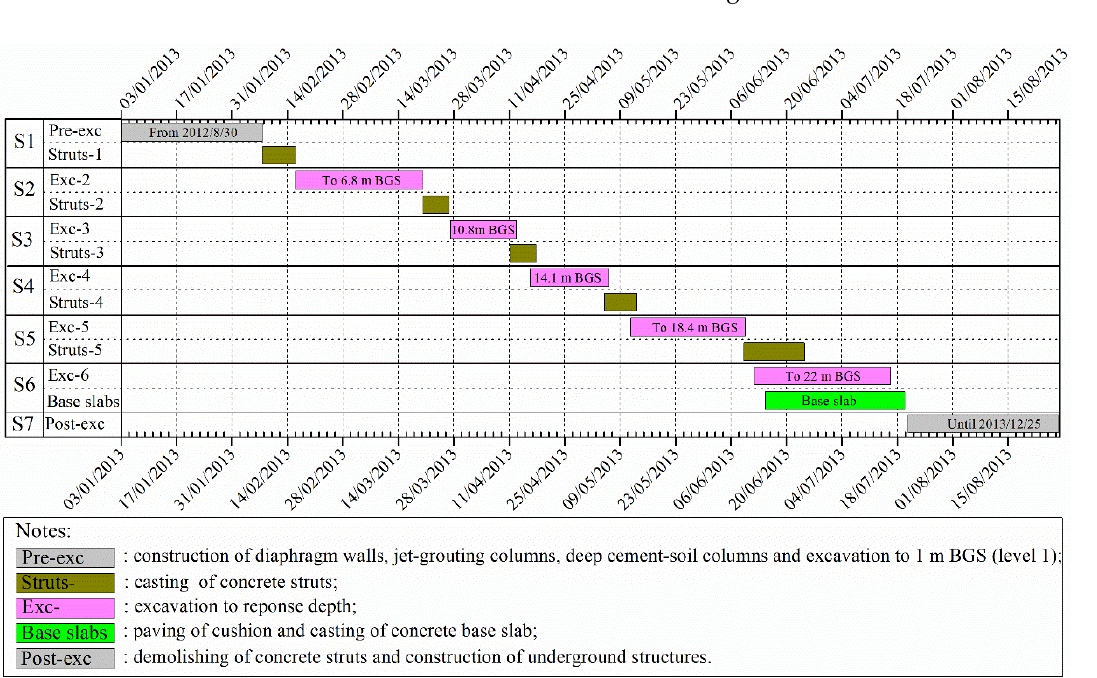
Figure 3. Main construction sequences of the